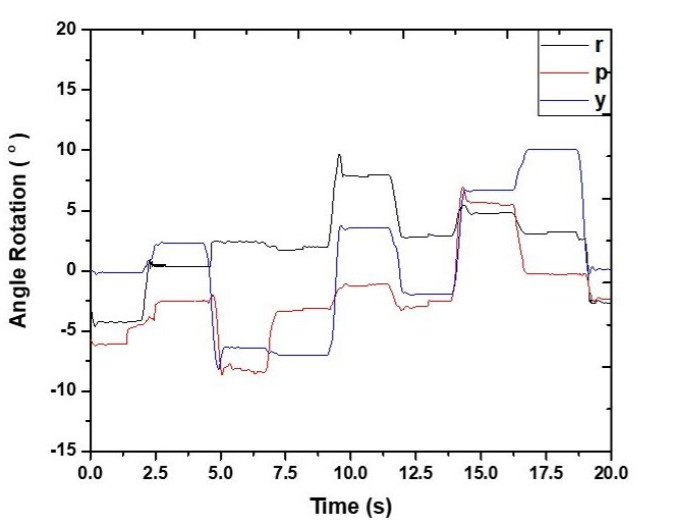
Figure 8. IMU results for a single